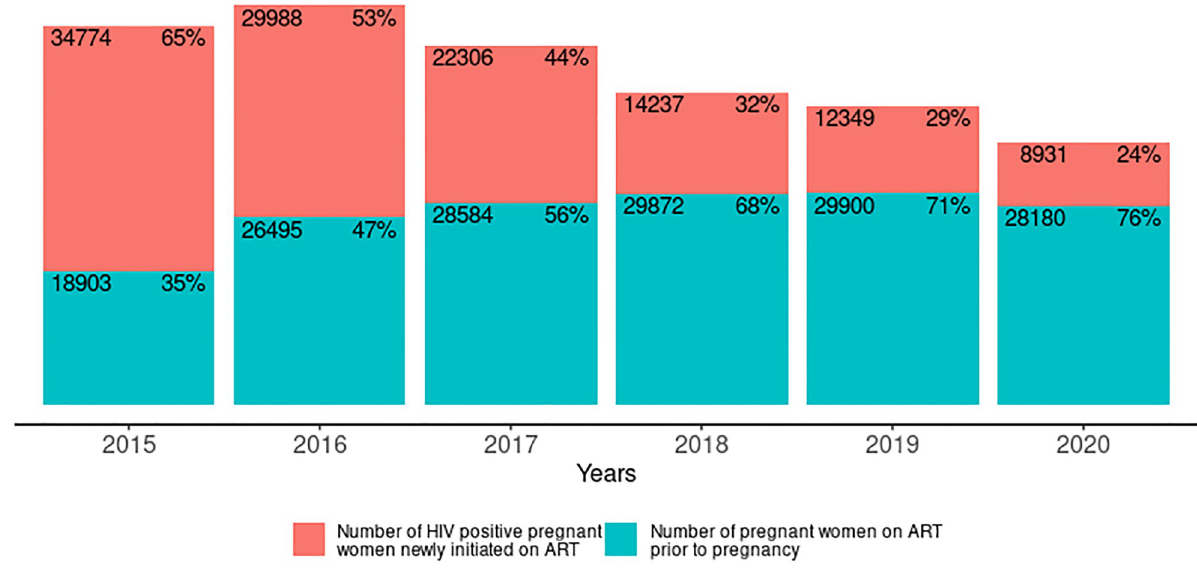
Fig 9. Number of HIV positive pregnant women on antiretroviral treatment annually disaggregated by new initiation on treatment and already on treatment from 2015–2020.